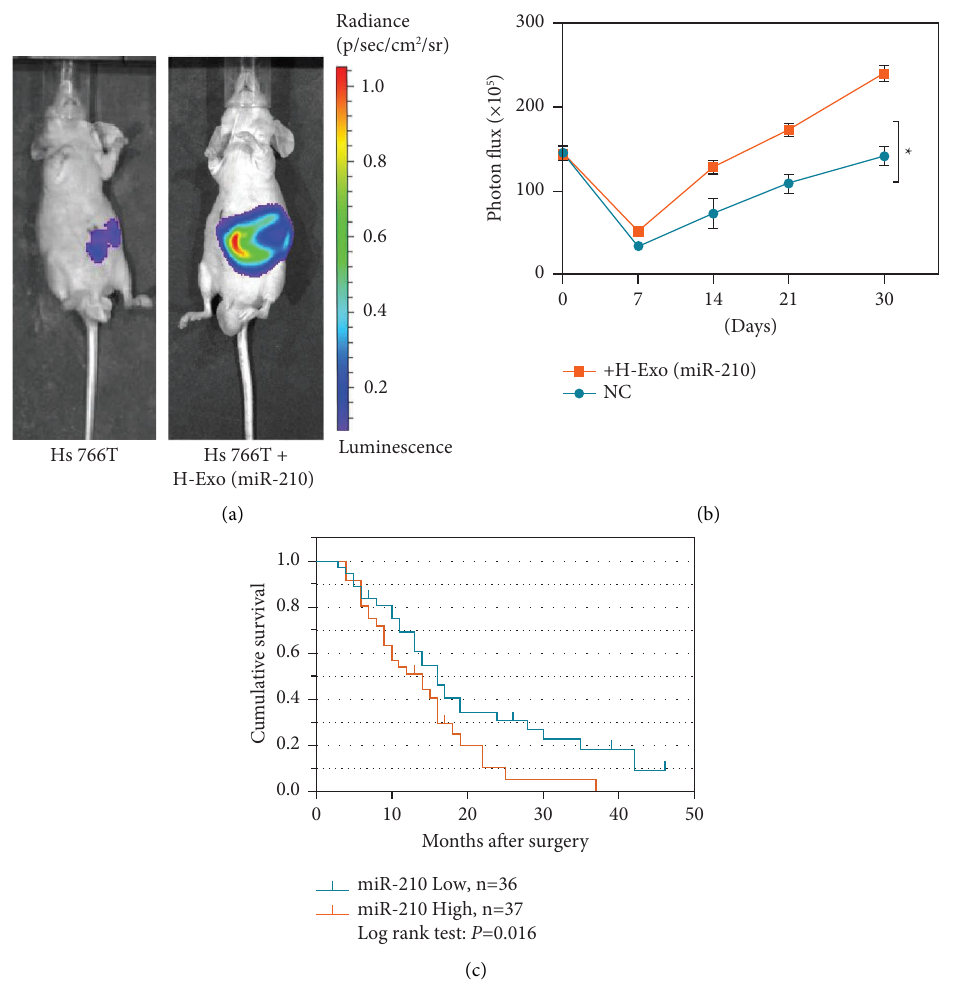
Figure 8: miR-210 promotes tumor progression in vivo . (a–b)In animal experiments, the luciferase intensities were measured each week after intrapancreatic injection with NC or the indicated treated cells. (c) K–M survival curves for the overall survival of 73 PDAC patients according to the relative expression of exosomal miR-210. Table 2: Univariate and multivariate survival analyses of the prognostic factors associated with survival in pancreatic carcinoma patients ( n �